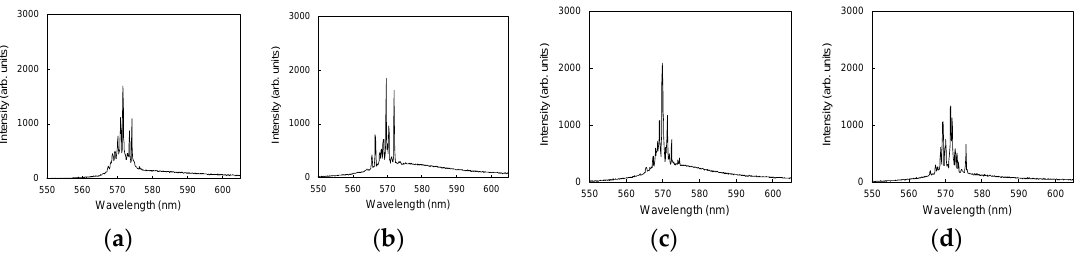
Figure 6. Emission spectra obtained with the stripe excitation pattern for SP volume fractions of ( a ) 0%, ( b ) 5%, ( c ) 10%, and ( d ) 15%. The volume fraction of scattering particles is 10%. The pumping energy and energy density are 13 µJ and 22.8 µJ/mm 2 , respectively.